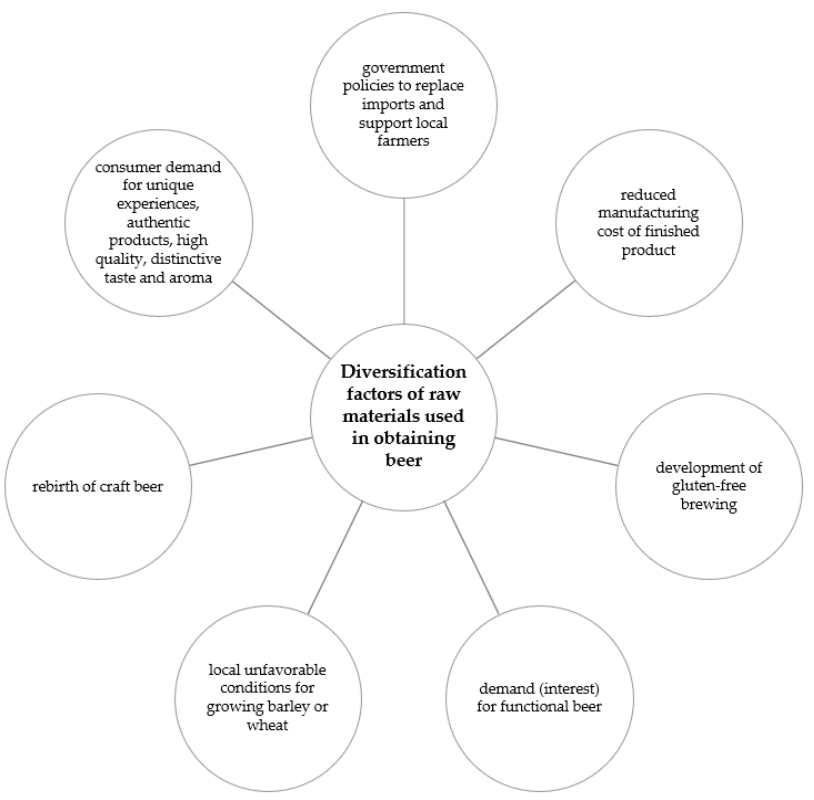
Figure 1. Diversification factors of raw materials for obtaining beer.